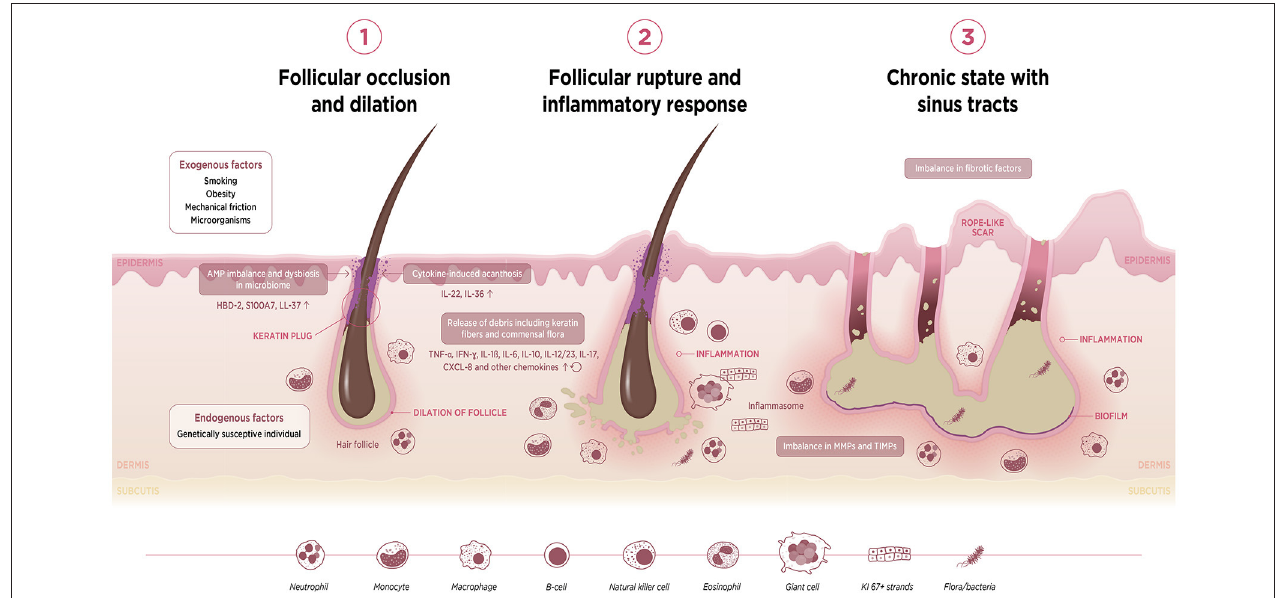
FIGURE 2 | Schematic diagram to illustrate postulated sequence of events underlying HS pathophysiology. AMP, antimicrobial protein; HBD, human beta-defensin; IFN, interferon; IL, interleukin; MMP, matrix metalloproteinase; TIMP, tissue inhibitor of metalloproteinase; TNF, tumor necrosis factor.